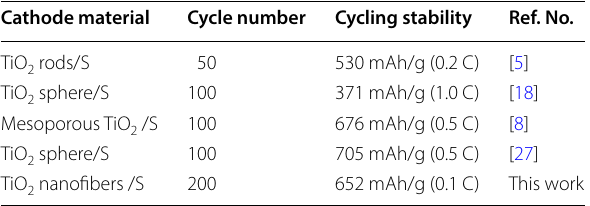
Table 1 Electrochemical performance